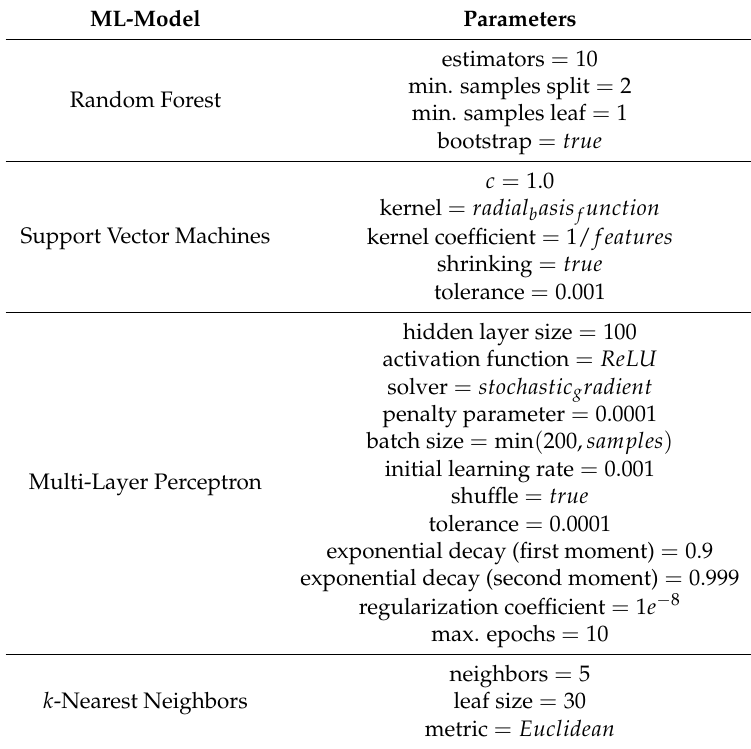
Table 12. Parameter settings for ML-models of the